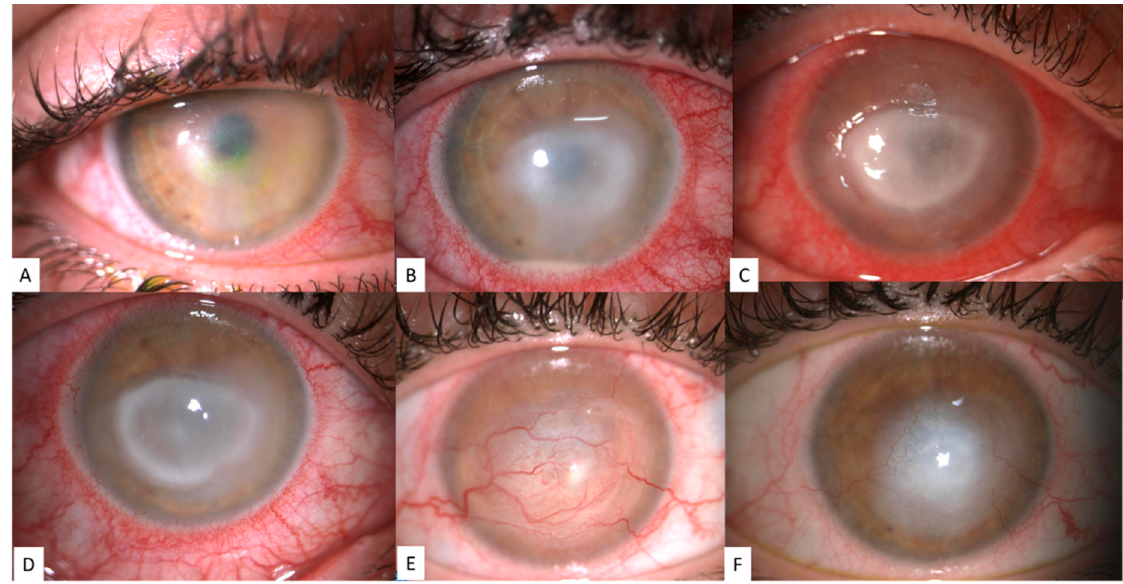
Figure 1. Representative images of the clinical evolution of Acanthamoeba keratitis (AK): early phase AK showing epithelial keratopathy ( A , stage I) [3], stromal involvement and sterile hypopyon ( B , stage II) [15], epithelial defect and ring stromal infiltrate ( C , D , stage III) [11], and corneal scarring with deep and superficial neovascularization ( E , F ).